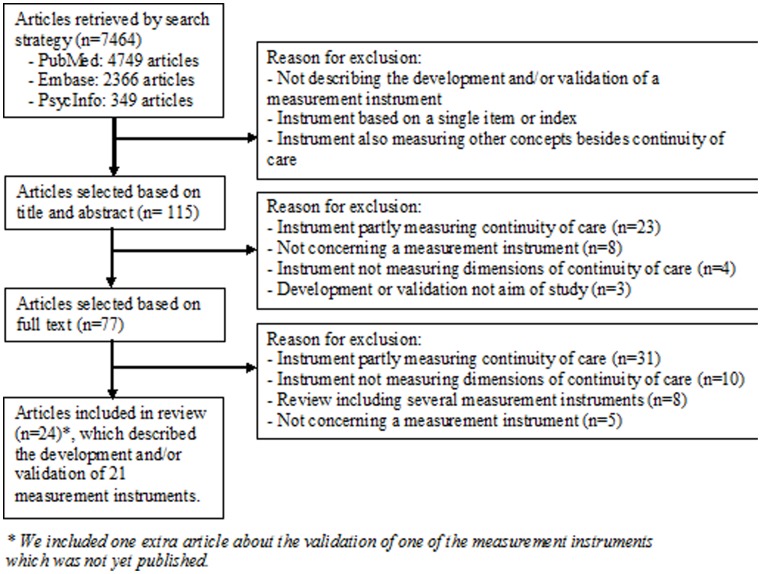
Search strategy resulting in 4749 articles from PubMed, 2366 articles from Embase and 349 articles from PsycInfo.